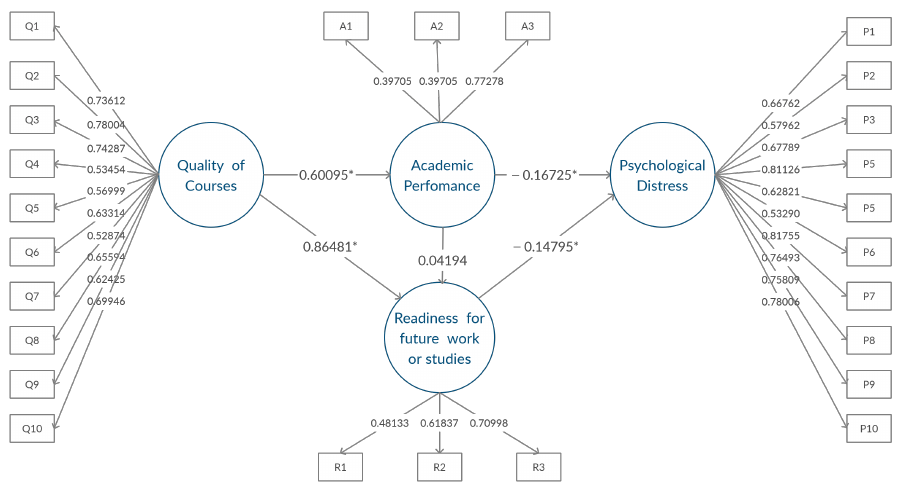
Figure 1. Conceptual research model, * significant relationship between latent